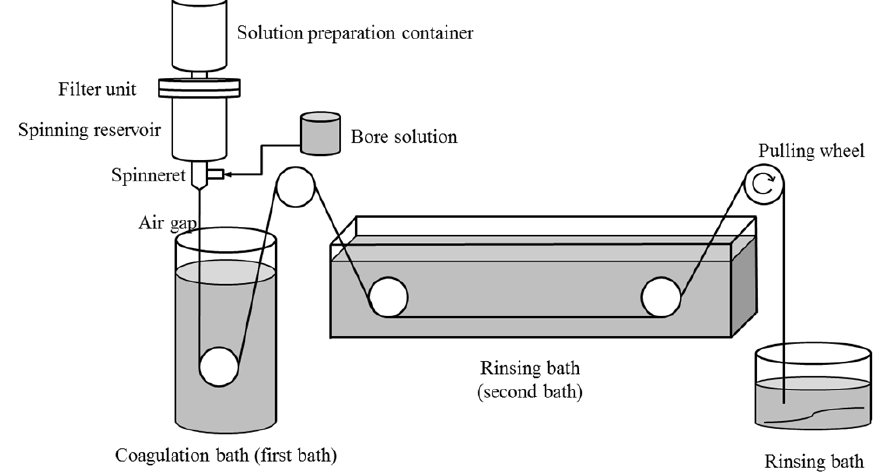
Figure 1. Schematic diagram of the spinning process.